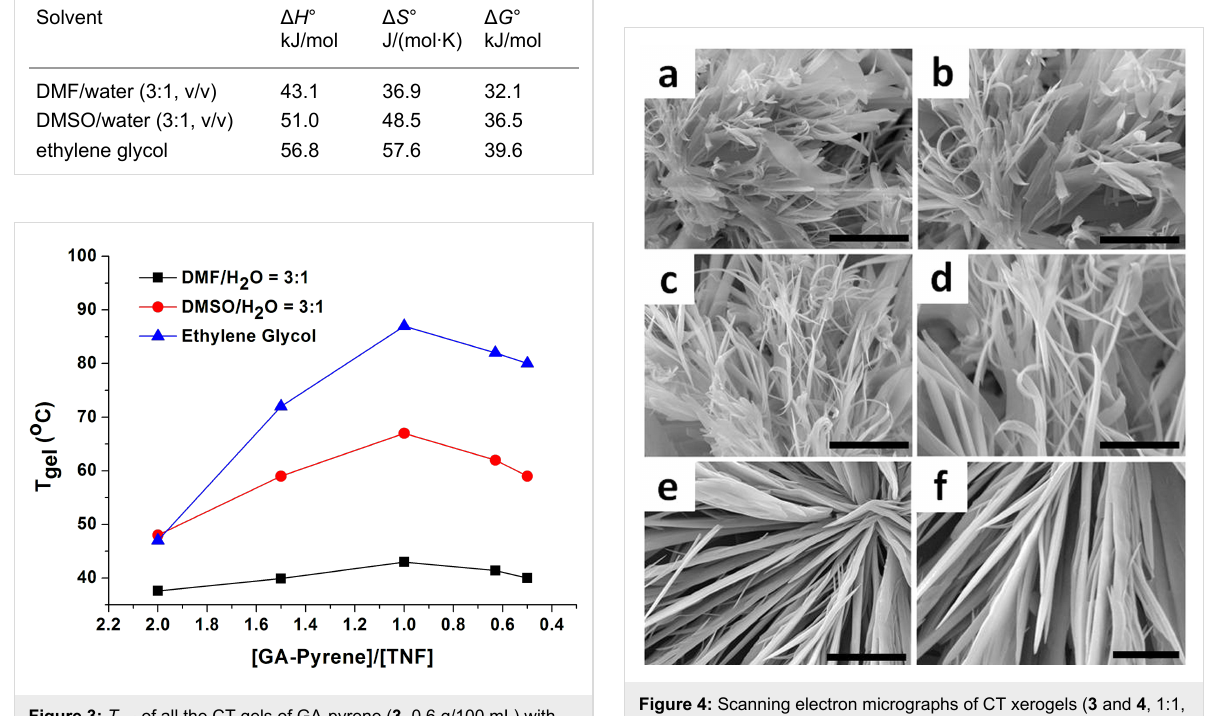
Figure 3: T gel of all the CT gels of GA-pyrene ( 3 , 0.6 g/100 mL) with TNF ( 4 ) in varying ratios. which was caused by the degree of aggregation of the donor and the acceptor in these CT gels.